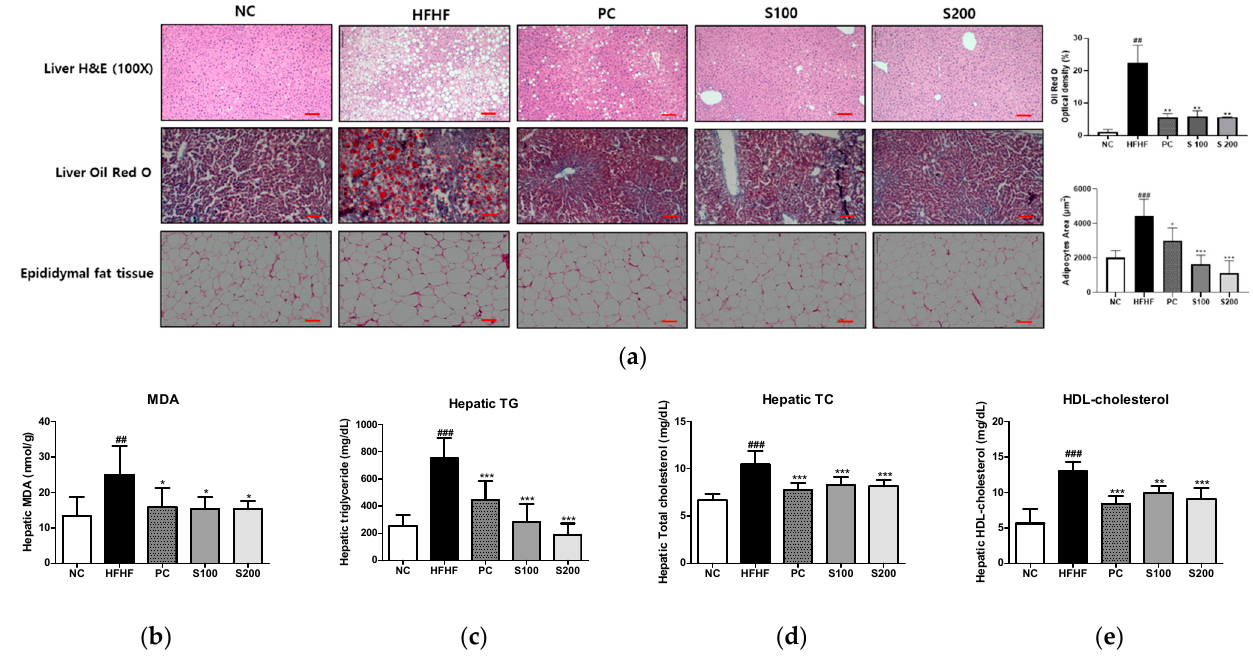
Figure 5. Effects of Bombyx mori (SW) on hepatic steatosis and hepatic parameters in HFHF-fed mice. ( a ) Liver tissue histology (100×), Liver Oil Red O, and H&E staining of epididymal white adipose tissue. ( b ) Hepatic MDA levels. The accumulation of liver TG ( c ), TC ( d ), and HDL-cholesterol ( e ). H&E, hematoxylin and eosin; MDA, malondialdehyde; TG, triglyceride; TC, total cholesterol; HDL-cholesterol, high-density lipoprotein-cholesterol; NC, normal control; HFHF, 45% high fat diet with 10% fructose in the drinking water (HFHF) control; PC, positive control (HFHF diet with 1% silymarin); S100, HFHF diet with SW (100 mg/kg/day); S200, HFHF diet with SW (200 mg/kg/day). The results from three independent experiments are expressed as the means ± SE. ## p < 0.01 and ### p < 0.001 vs. NC; * p < 0.05, ** p < 0.01, and *** p < 0.001 vs. HFHF. The scale bar shows 100 μ m .